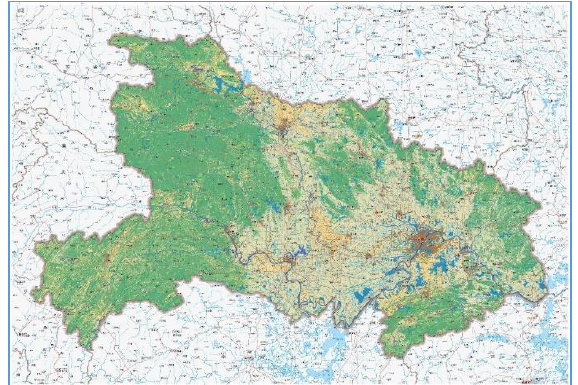
Figure 7. The surface coverage map of Heilongjiang province